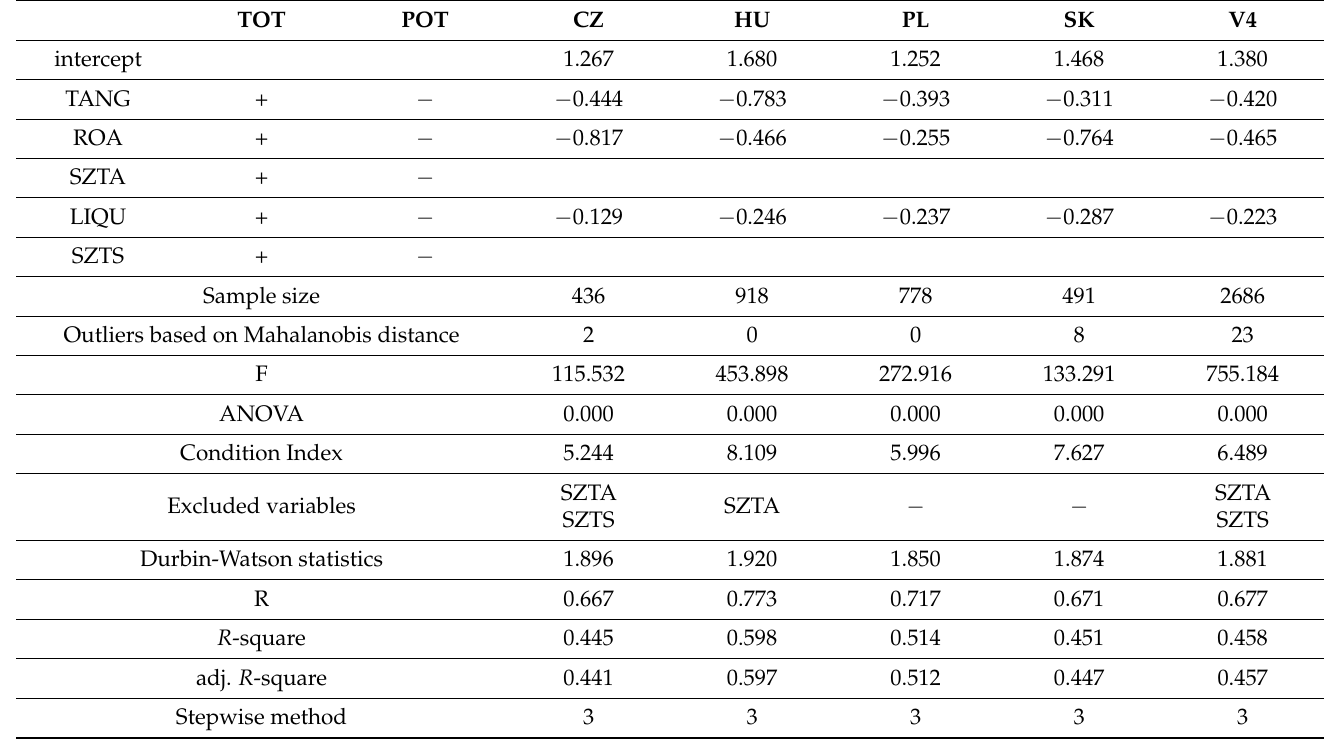
Table 7. Multiple linear regression